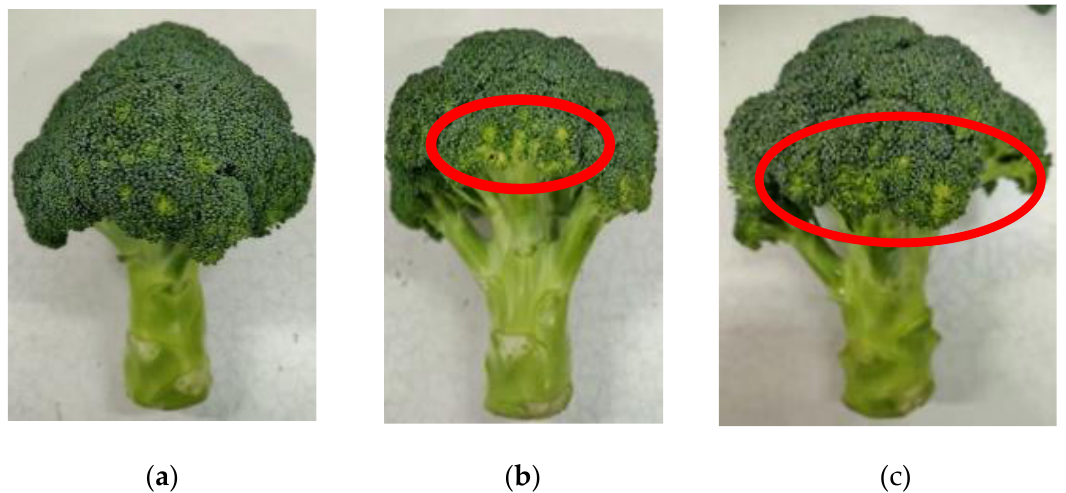
Figure 5. Broccoli physical damage test: ( a ) Flower ball pressure test; ( b ) Stem-cutting force test.